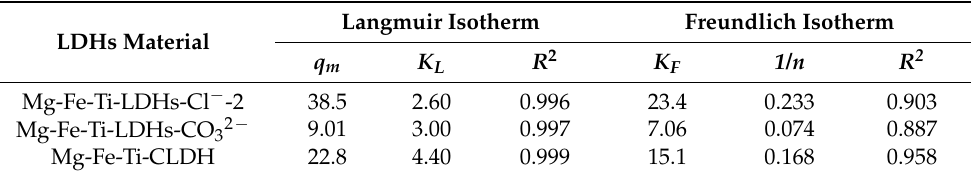
Table 1. Adsorption isotherm models of VO 3 − adsorption onto Mg-Fe-Ti-LDHs-Cl − -2, Mg-Fe-Ti- LDHs-CO 32 − and Mg-Fe-Ti-CLDH. LDHs